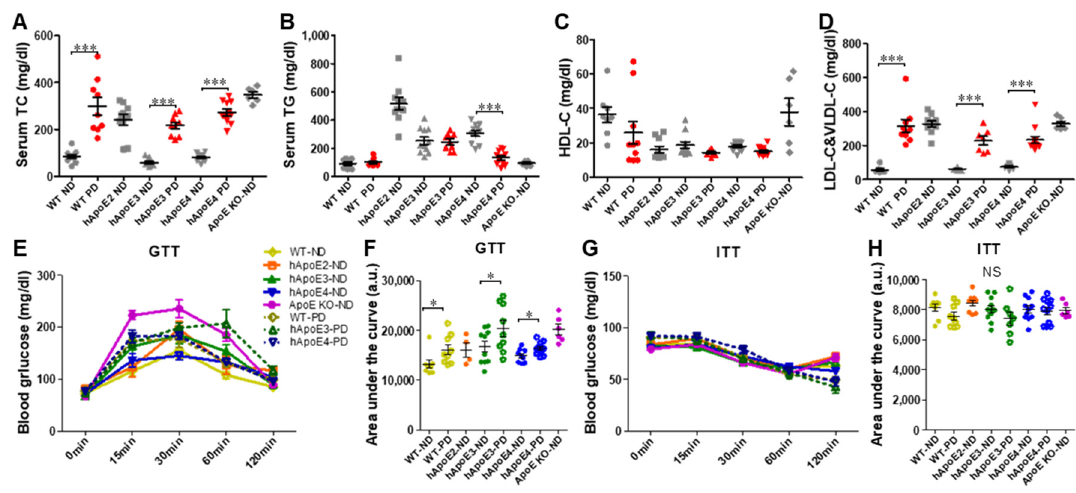
Figure 7. Metabolic changes in WT, hApoE3, and hApoE4 rats with 4 months of the PD. ( A – D ) Serum lipid levels were analyzed at age 6 months with or without PD feeding (TC and TG: WT n = 9 vs. 9, hApoE2 n = 10, hApoE3 n = 11 vs. 9, hApoE4 n = 11 vs. 11, and ApoE KO n = 6; WT n = 8 vs. 9, hApoE2 n = 10, hApoE3 n = 11 vs. 7, hApoE4 n = 11 vs. 12, and ApoE KO n = 6). ( E , F ) GTT was performed on rats at age 6 months (WT n = 8 vs. 9, hApoE2 n = 4, hApoE3 n = 10 vs. 9, hApoE4 n = 9 vs. 12, and ApoE KO n = 6). ( G , H ) ITT was performed on rats at the same age (WT n = 8 vs. 9, hApoE2 n = 9, hApoE3 n = 11 vs. 7, hApoE4 n = 11 vs. 11, and ApoE KO n = 6). (Two-way ANOVA followed by a Bonferroni post hoc test.